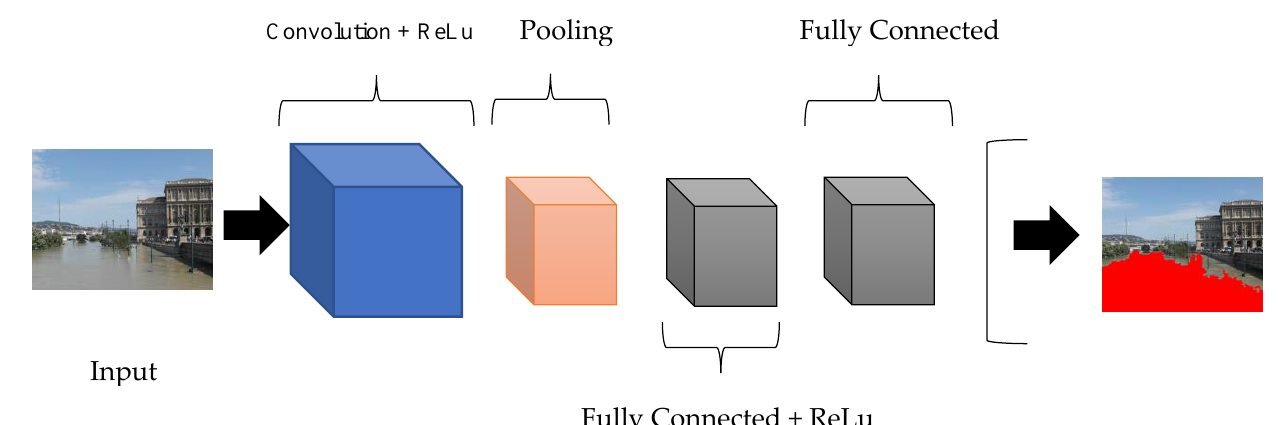
Figure 8. Proposed architecture diagram of CNN.